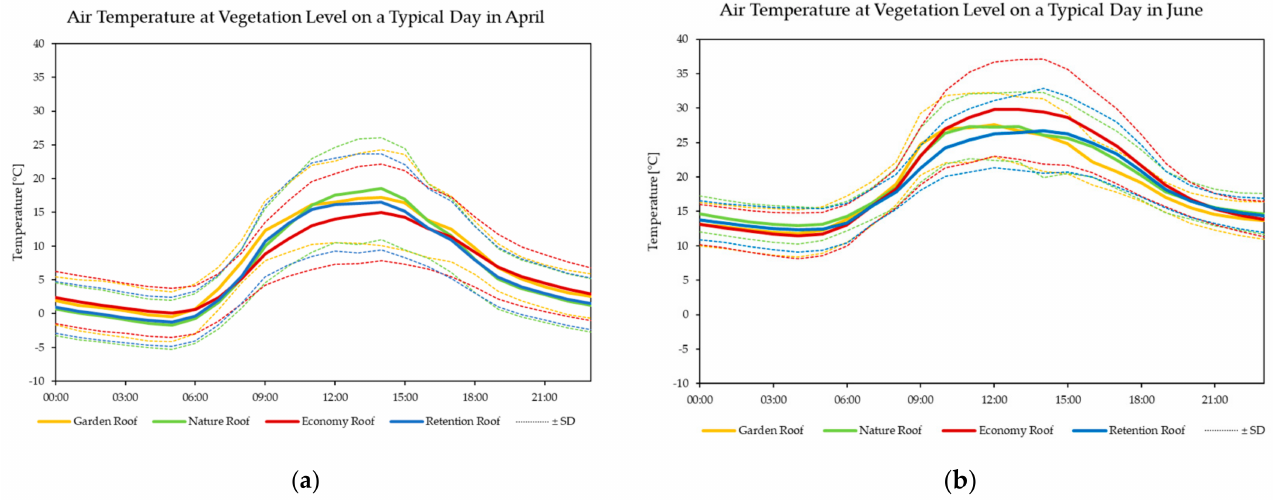
Figure 11. Air temperatures at vegetation level on an average day for the four different green roofs in: ( a ) April; ( b ) June. For each single day in April and June, the raw data were aggregated to 24-hourly means. Shown are means ± SD for each hour of 30 days in April and June, respectively (n =